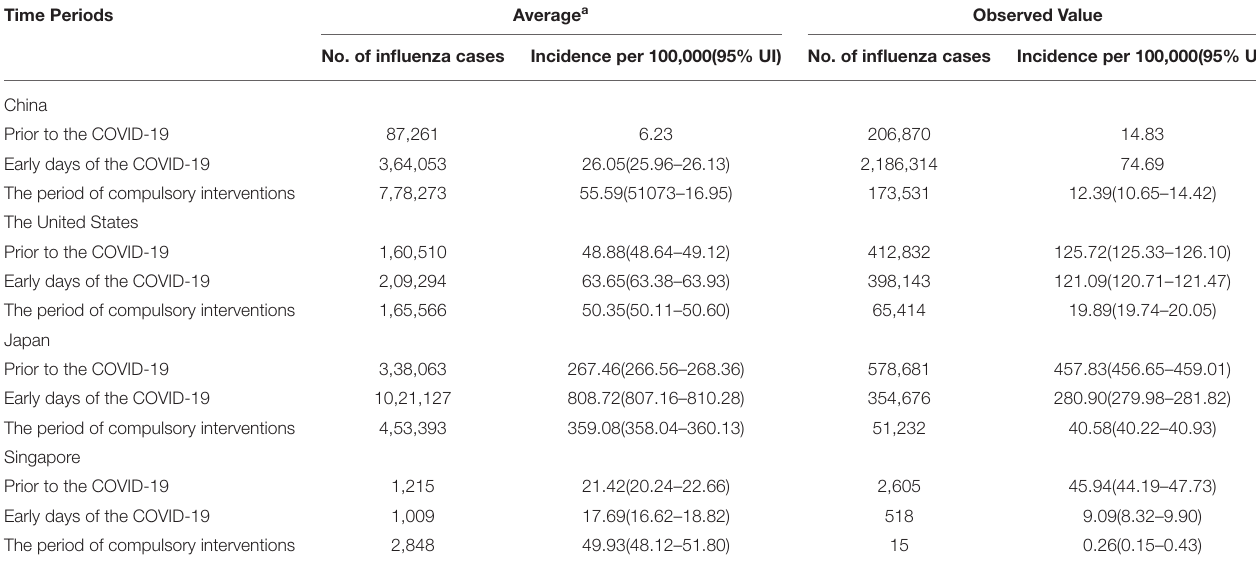
TABLE 1 | Incidence of influenza in the 2019–2020 season stratified by time periods and average in four